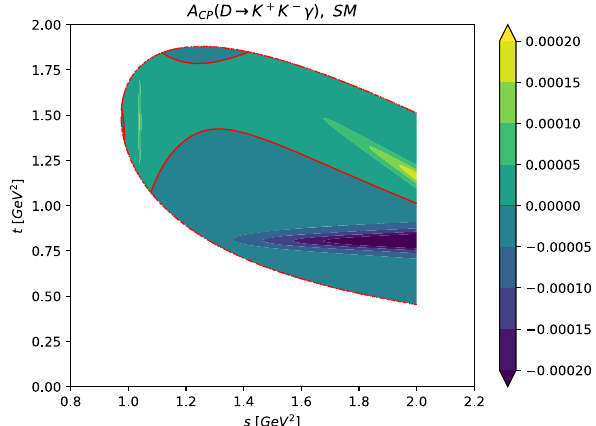
Fig. 14 Dalitz plot of A SM HH χ PT for s ≤ 2GeV